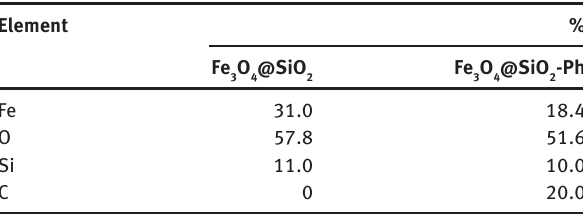
Figure 4: The effects of the amount of the Fe extraction efficiency of selected PEs. (Sonication time = 30 min; desorption solvent = methanol; desorption time = 1 min; without pH adjustment).